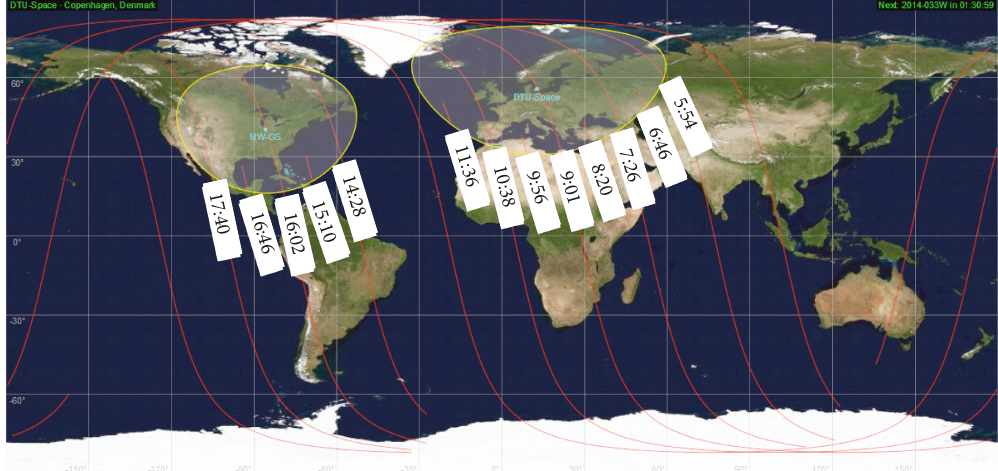
Figure 12: Map of the Earth with the two ground stations listening for DTUsat-2: one in Indiana, USA, and one in Denmark. The perimeter of each ground station is indicated with a yellow line. The red lines on the map are satellite trajectories. The time stamps at the perimeters of the fi eld of views correspond to di ff erent satellite pass start times in UTC. Knowing the satellite pass start time allows for the determination of which trajectory the satellite will follow during the